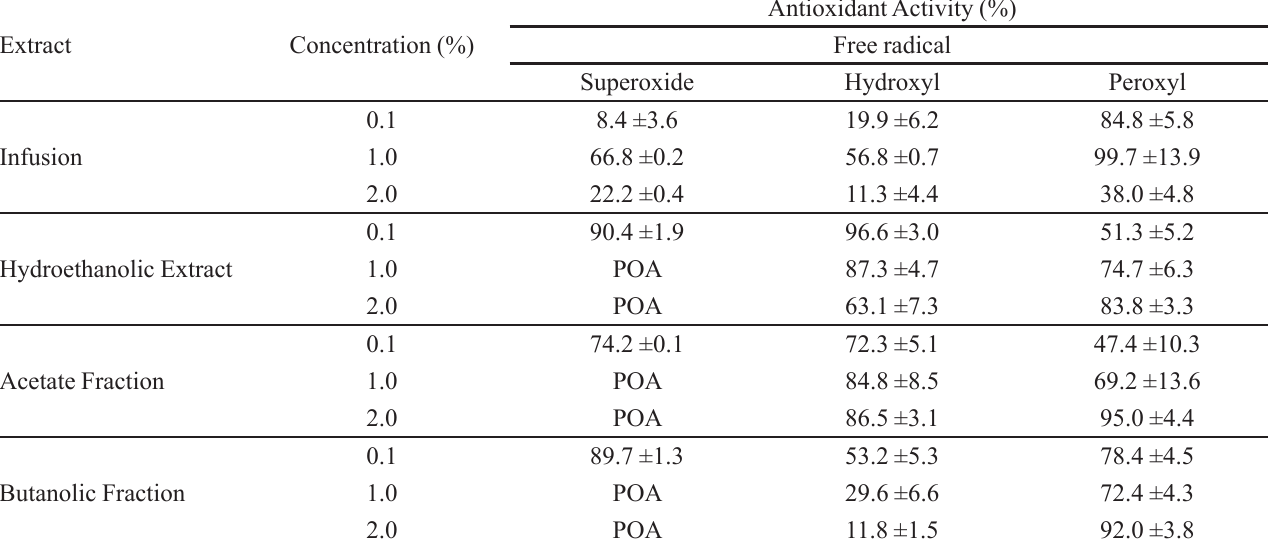
TABLE IV - Antioxidant activity of different extracts of Jatropha gossypiifolia against superoxide, hydroxyl and peroxyl radicals